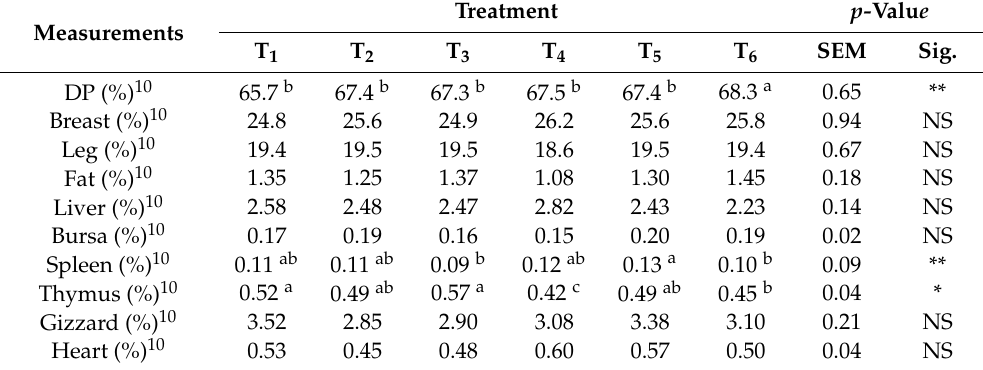
Table 3. E ff ects of some feed additives on the carcass traits of broilers challenged with C. perfringens during the starter and finisher feeding periods.